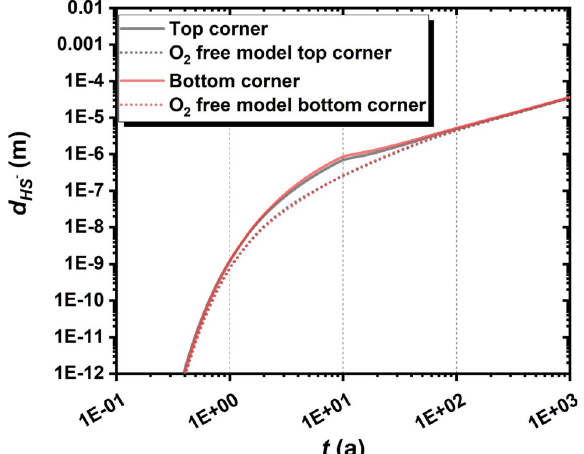
Fig. 14 Corrosion depth evolution with time. Corrosion depth ( d HS (cid:3) ) at top and bottom corners of copper canister with and without O 2 .